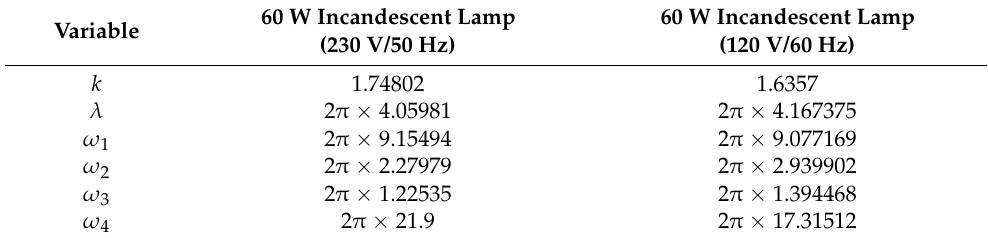
Table 1. Parameters of the visual sensitivity weighted